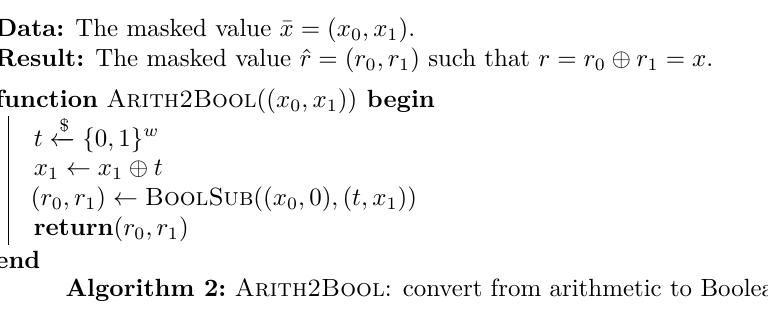
Algorithm 2: Arith2Bool : convert from arithmetic to Boolean masking.